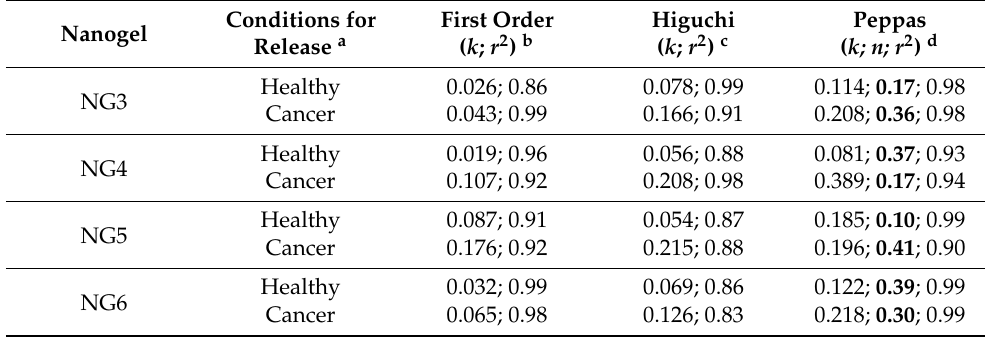
Table 3. Release rate for DOX: in vitro release data fitted with different